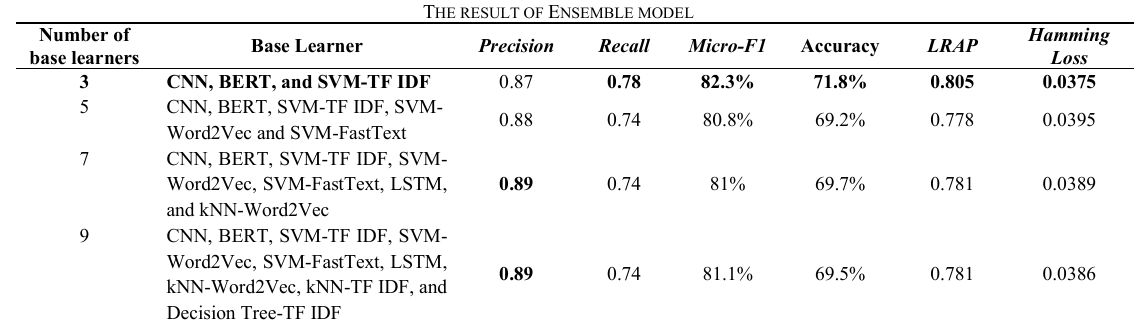
TABLE 4 T HE RESULT OF E NSEMBLE